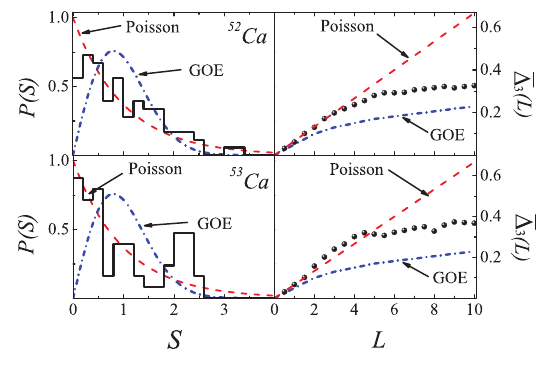
Figure 4. Level spacing distribution P ( S ) (left panel) and spec- tral rigidity ∆ 3 ( L ) (right panel) for the J = 0 levels in 52 Ca with G = 0 . 175 MeV and for the J = 3 / 2 levels in 53 Ca with G = 0 . 03 MeV. P ( S ) and ∆ 3 ( L ) for 52 Ca and 53 Ca are of the Poisson